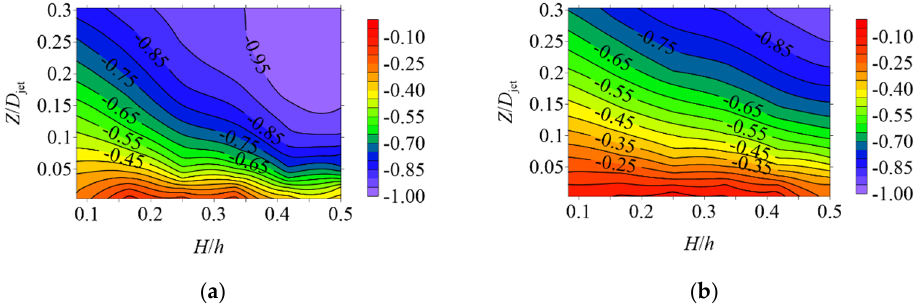
Figure 23. Contour maps of vertical wind velocity ( r h = 0.0 D jet ): ( a ) L = 0.5 D jet ; ( b ) L = 1.0 D jet .